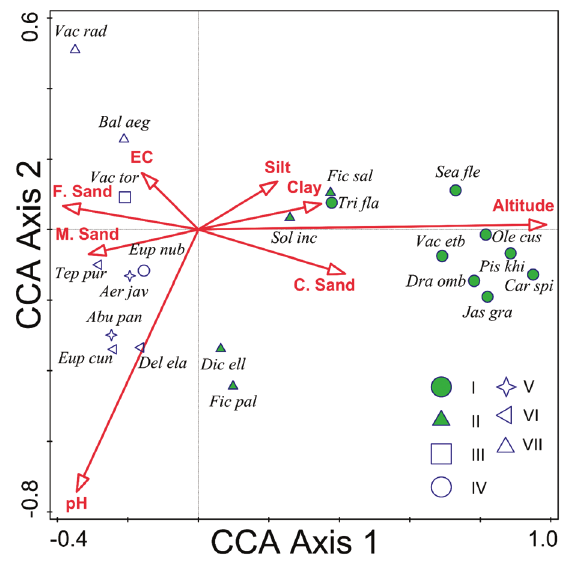
Figure 6. CCA ordination showing the relation between perennial species with phi coefficient > 0.25 and envi- ronmental factors represented by altitude and seven soil parameters. Variation is mostly explained by elevation (Alt), soil texture and pH. The lower left part contains species from Wadi Kansisrob. The upper part contains species of the open sandy plain, Wadi Yahmib. The right part contains evergreen species from mid to higher ele- vations. Eigenvalues for biplot scaling are 0.60 for axis 1 and 0.16 for axis 2 and the adjusted explained variation is 11.54%. The legend is placed at the lower right part of the figure. The diagnostic species for each community are represented by different symbols; solid symbols for communities of higher elevations and hollow symbols for communities from low to middle elevations. For spe- cies and sand fractions abbreviations see Tables 1, 3.